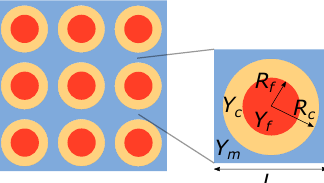
Figure 2. Lattice of the LRM and zoom over a unit cell composing it. R f and R c are respectively the fiber and coating external